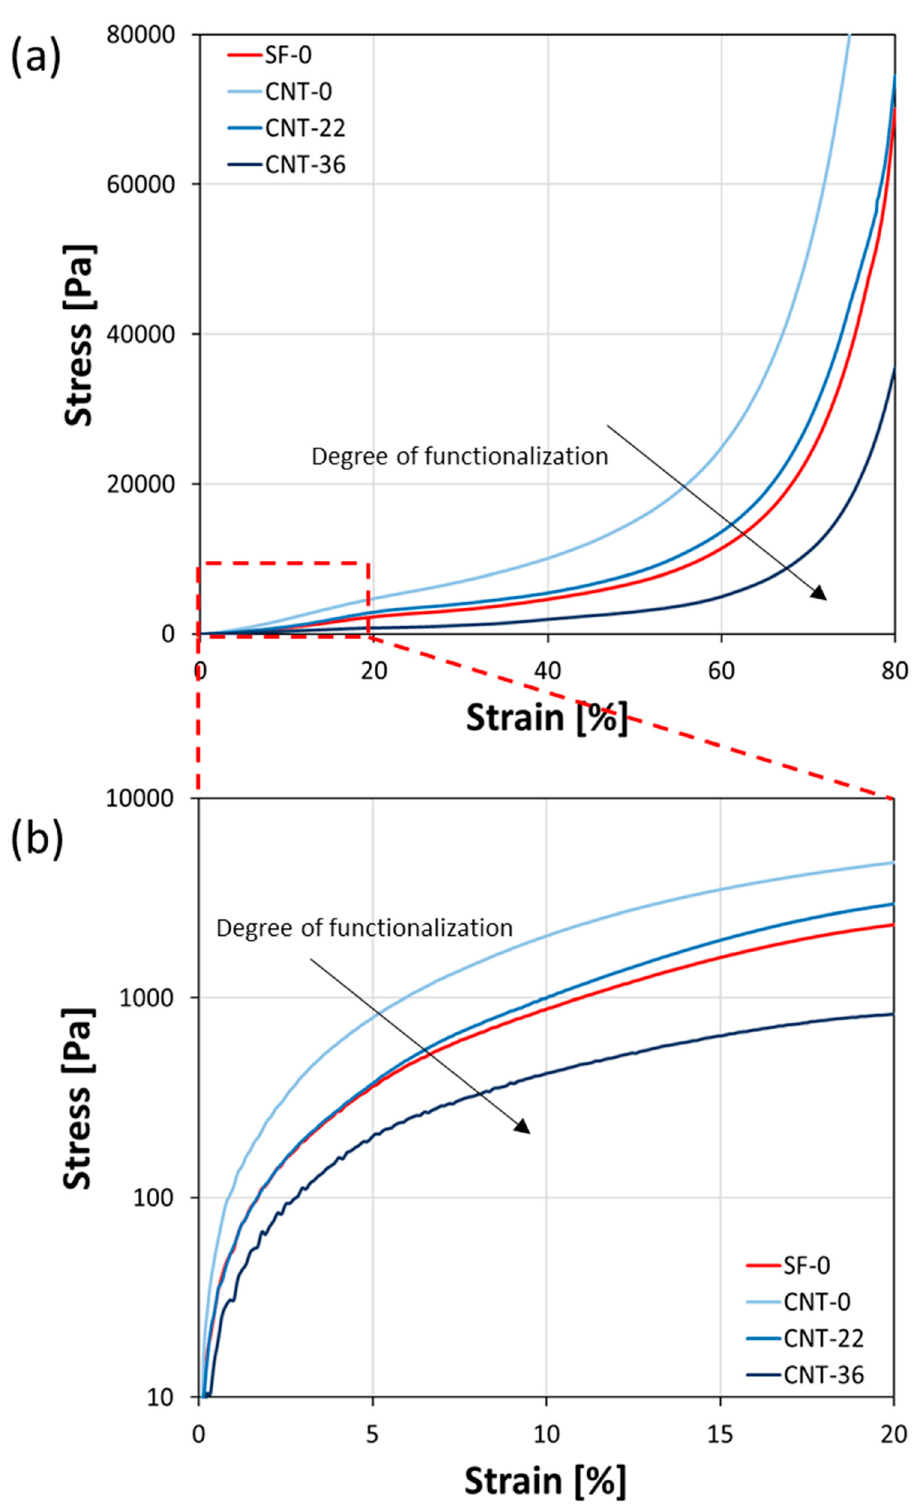
Figure 7. Stress–strain curves of composite foams ( a ), magnification of up to 20% strain ( b ).